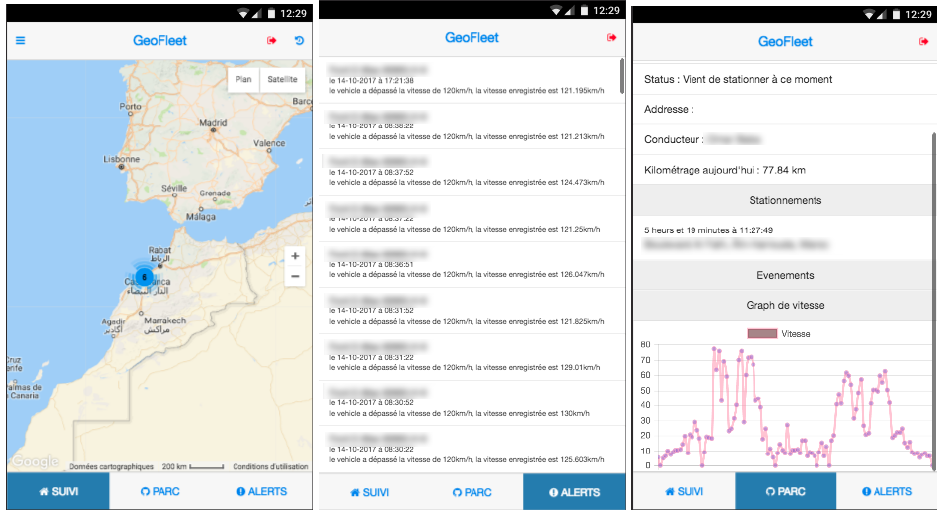
Figure 17. Mobile framework application. Example of simultaneous information provided by the system: traces on map users’ information and